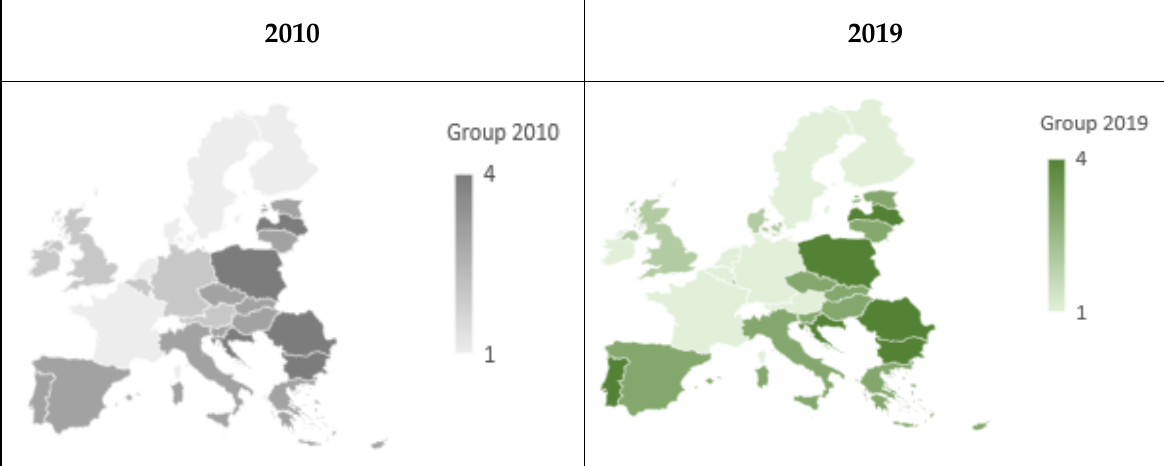
Figure 3. Classification of the EU countries into particular groups based on the value of the synthetic measure in 2010 and 2019. Source: Authors’ own compilation based on Eurostat data; visualization supported by Bing, Geonames, Microsoft, TomTom.